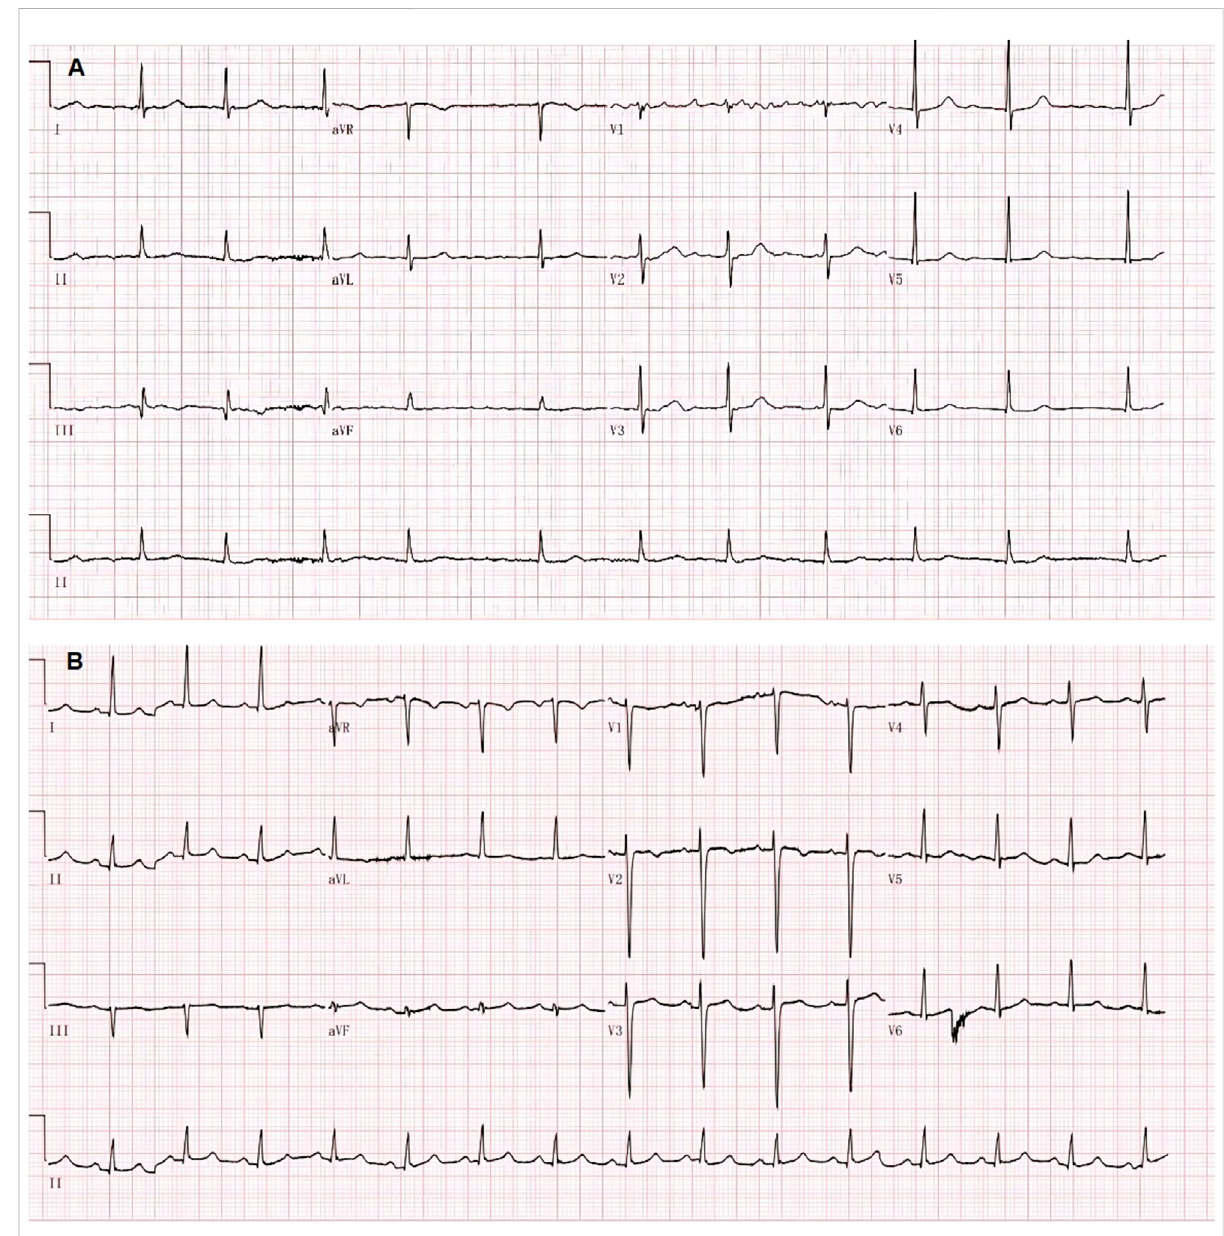
FIGURE 1 Changes in the electrocardiogram. (A) after admission; (B) on day twelve of